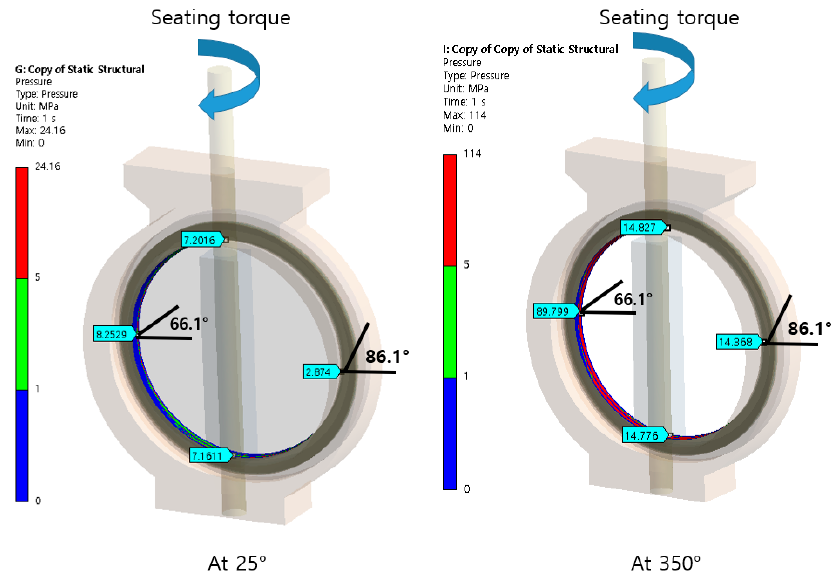
Figure 17. The contact pressure distribution of the five-layers model. The contact pressures of the seven-layers at the angles of 86.1 ◦ and 66.1 ◦ were 13.9 MPa and 1.59 MPa at 25 ◦ C, and 93.5 MPa (maximum) and 27.184 MPa at 350 ◦ C, respectively. The maximum contact stress (93.5 MPa) of the seven-layers at 350 ◦ C was lower than that of one-layer (282.5 MPa), three-layers (154.25 MPa), and five-layers (114 MPa). Therefore, this suggested adopting a seven-layer model to ensure that the valve disc is good at sealing and can rotate rapidly. The contact stress distribution is shown in Figure 18.